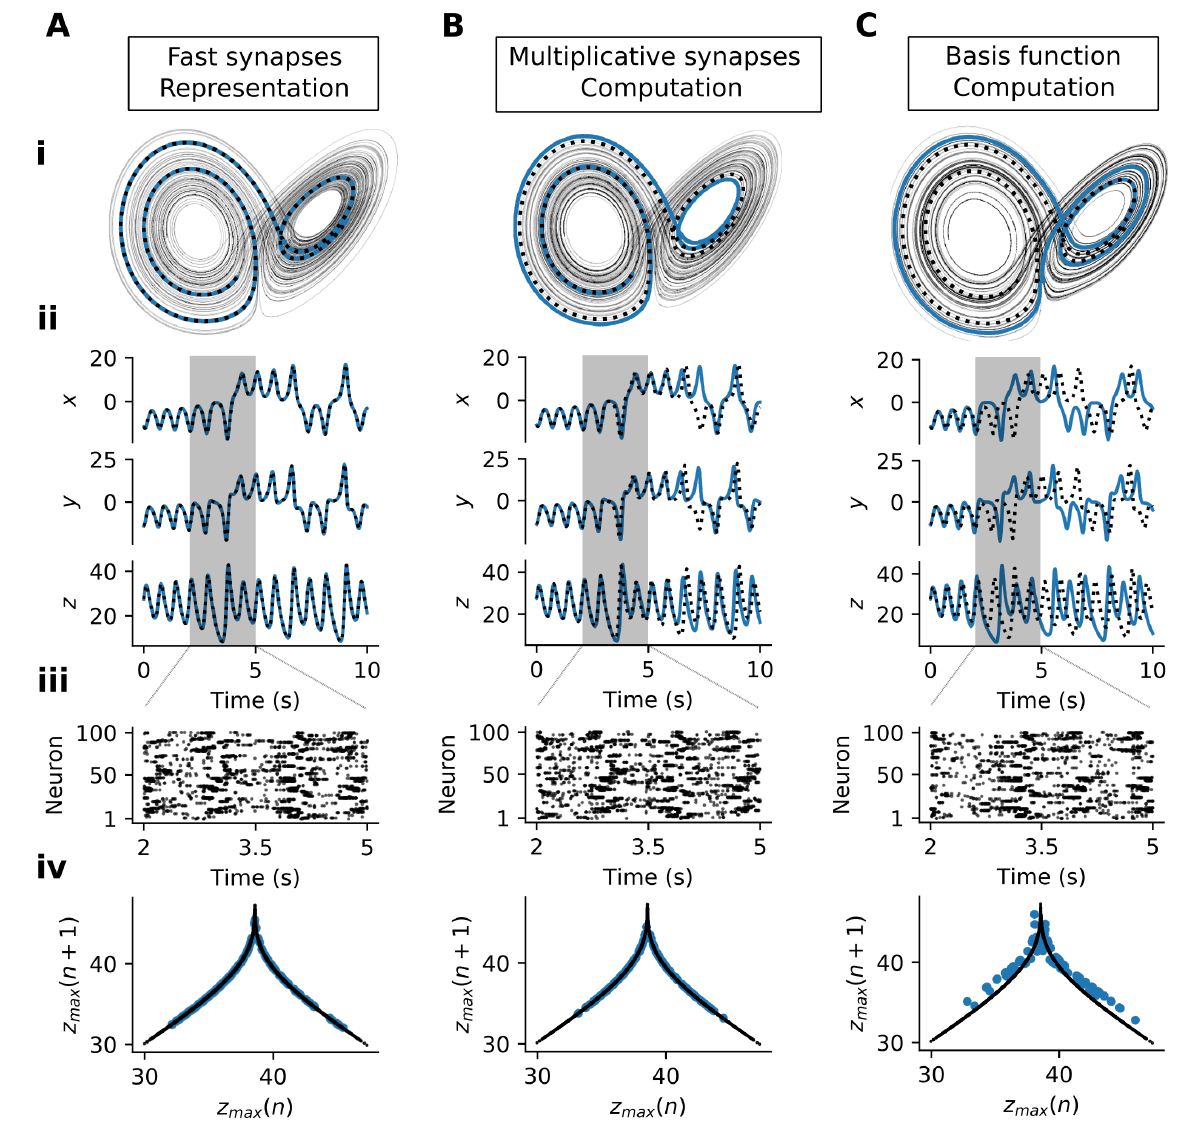
Figure 2 – Implementation of a Lorenz dynamical system. Across columns: (A) The numer- ical solution was found using an explicit Runge-Kutta method of order 4. The network contains only fast synapses and receives as input the output of the Lorenz simulation, which the network read-out tracks closely. (B) A network with multiplicative synapses (mSCN) computing the Lorenz attractor through its network dynamics. (C) A network with nonlinear basis functions computing the Lorenz attractor through its network dy- namics. Across rows: (i) 3D view of the network readout for 100 sec (grey). The dotted line shows the ‘true’ simulation in the 2-5sec period, and the blue line shows the corre- sponding network output trajectory. (ii) Each network readout dimension (blue) across time vs the ‘true’ solution (black dotted). The gray region indicates the 2-5sec period used in panels i and iii. (iii) Raster plot with spikes emitted by the neurons in the time interval 2 - 5 sec. (iv) Peak analysis over 100 sec: blue = network output, black = ‘true’ Lorenz